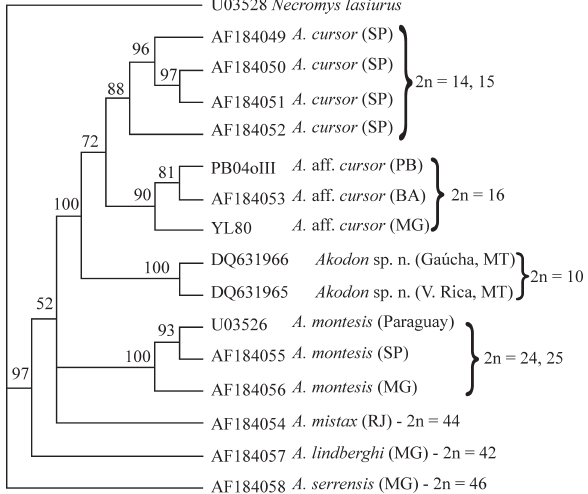
Figure 3 - Maximum parsimony majority consensus-tree (50% bootstrap) after a search with 100 replicates. Ninety-seven variable characters are parsimony uninformative and 558 are constant.